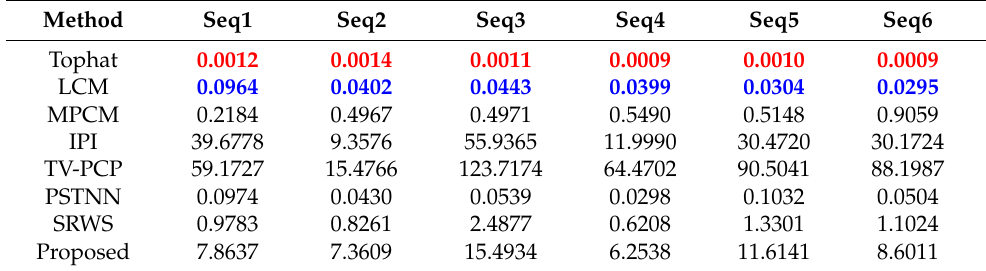
Table 4. Computation time (seconds) for all methods (bold red number: minimum value; bold blue number: second-smallest